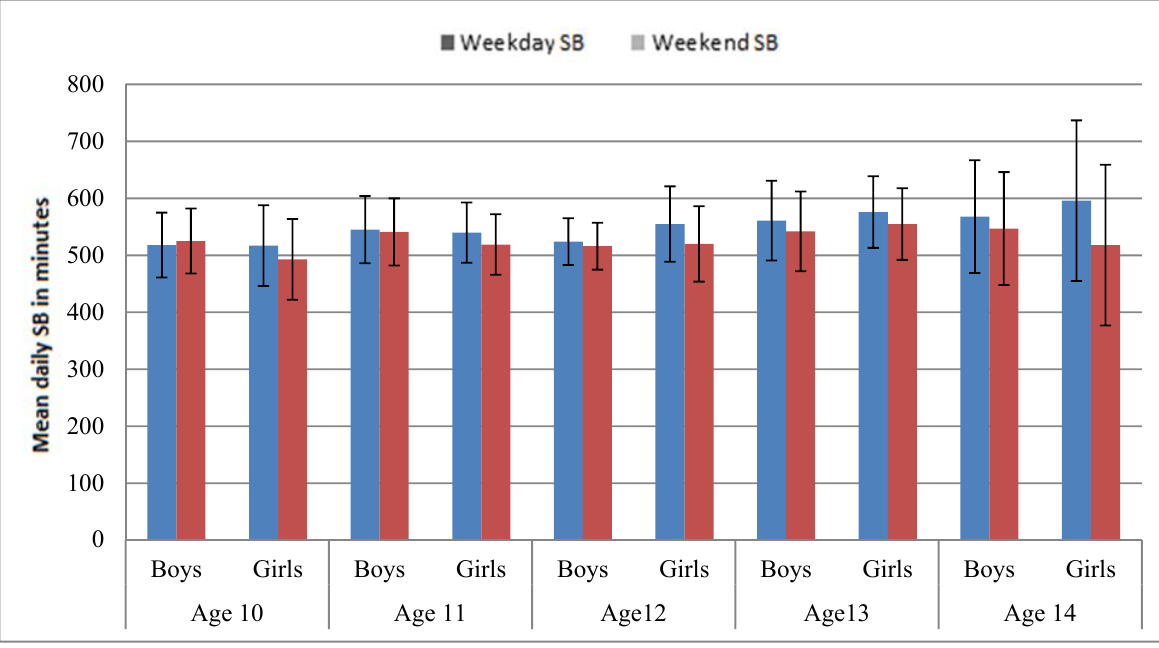
Figure 3. Mean daily sedentary behaviour on weekdays and weekend